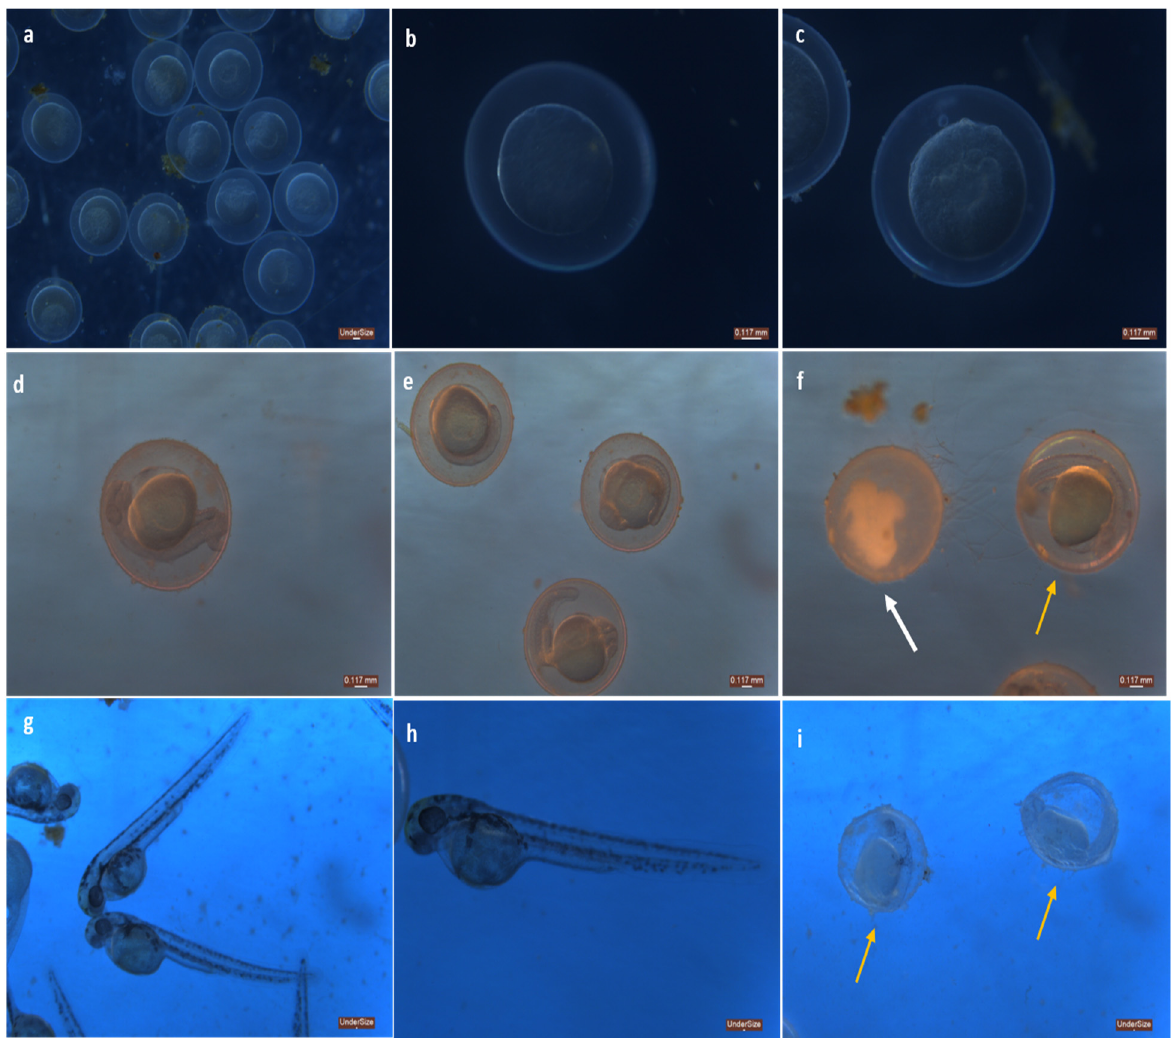
Figure 18. Microscopic images of Zebrafish— Danio rerio embryos ( a ) control at 0th h, ( b ) exposed to 10 µg at 0th h, ( c ) exposed to 20 µg at 0th h, ( d ) control at 24 hpf, ( e ) exposed to 10 µg at 24 hpf, ( f ) exposed to 20 µg at 24 hpf, ( g ) control at 48 hpf, ( h ) exposed to 10 µg at 48 hpf, ( i ) exposed to 20 µg at 48 hpf. White arrow denotes dead embryos (coagulation); Yellow arrows denote undeveloped embryos.